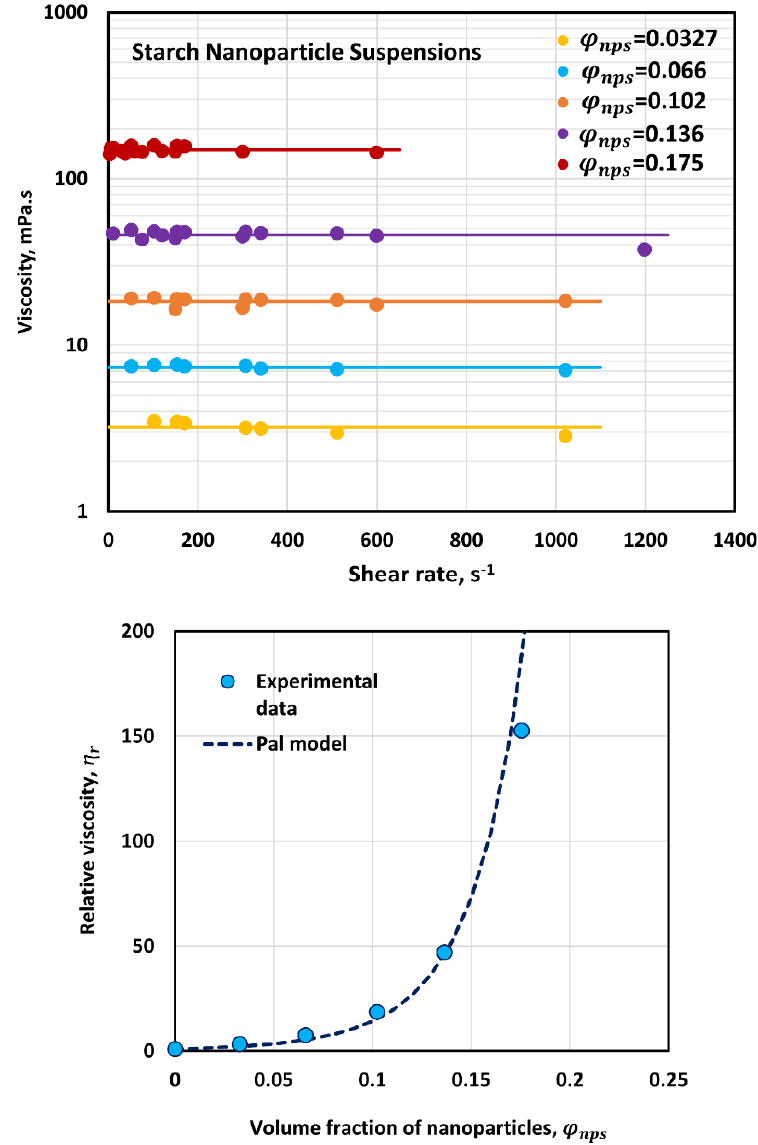
Figure 4. Viscous behavior of suspensions of starch nanoparticles.